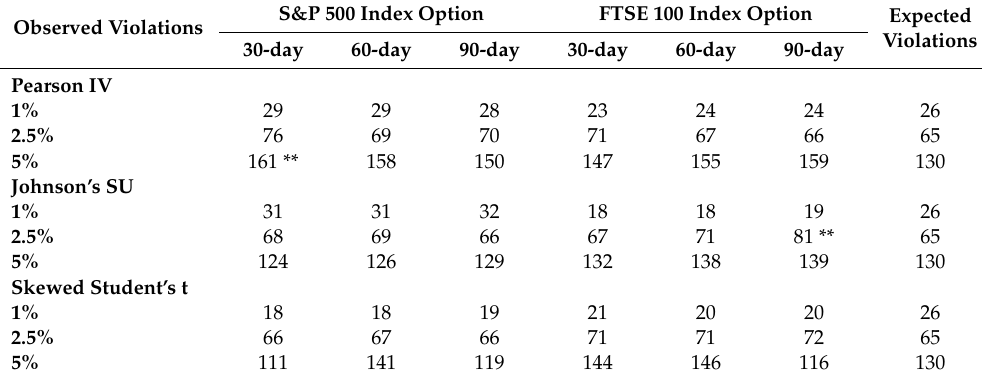
Table 3. Back-testing results for 10-day